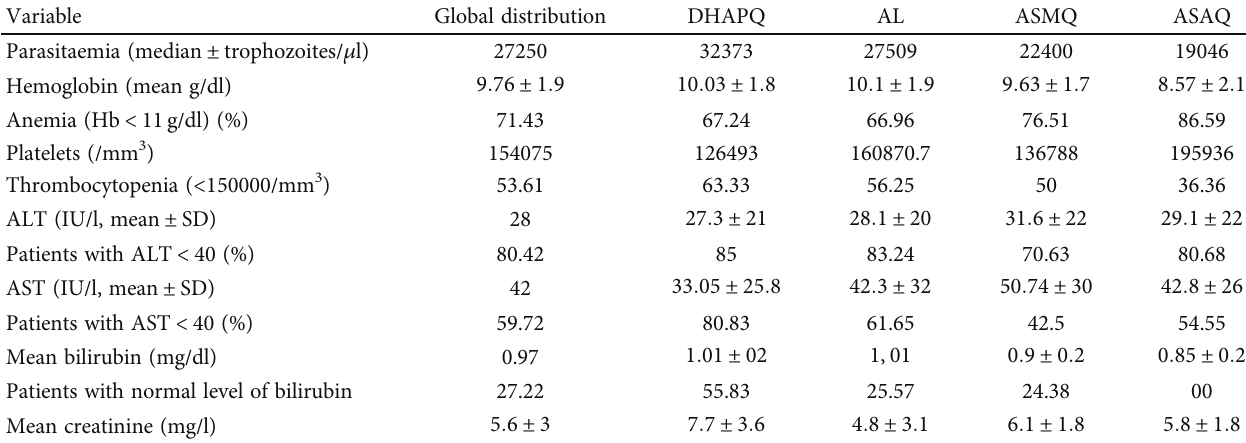
Table 2: Biological characteristics of patients at inclusion.